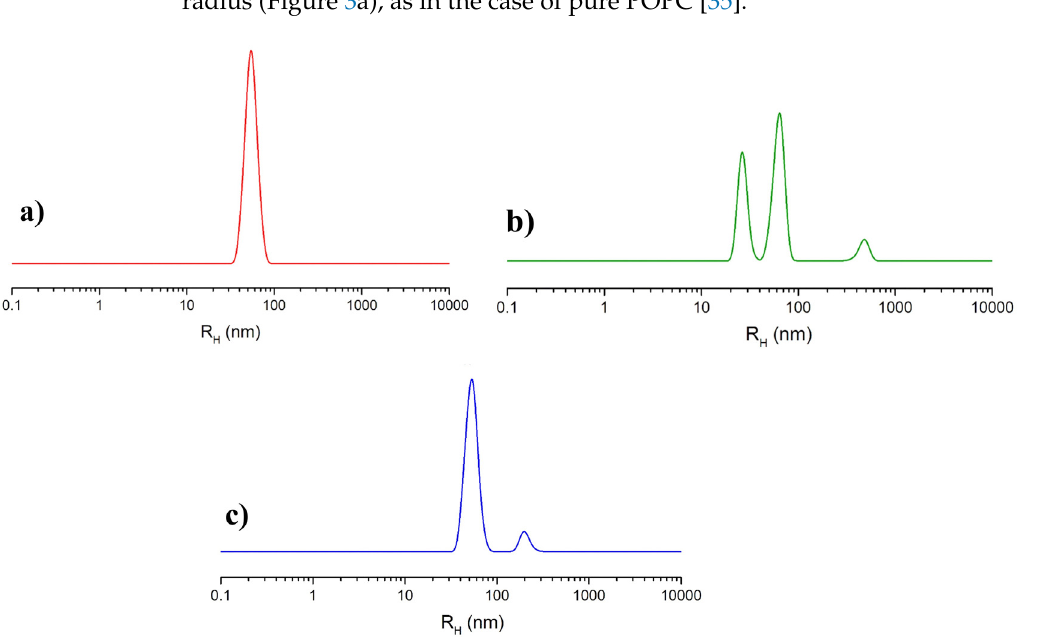
Figure 3. Hydrodynamic radius distribution function obtained through DLS measurements for the prepared liposome formulations: ( a ) extruded NOTA-OL/POPC 5:95 liposomes; ( b ) (Ga)NOTA-OL/POPC 5:95 liposomes obtained with preformed (Ga)NOTA-OL complex; ( c ) extruded NOTA-OL/POPC + Ga liposomes, formed by the addition of Ga(NO 3 ) 3 to preformed 1 mM NOTA-OL/POPC 5:95 liposomes.